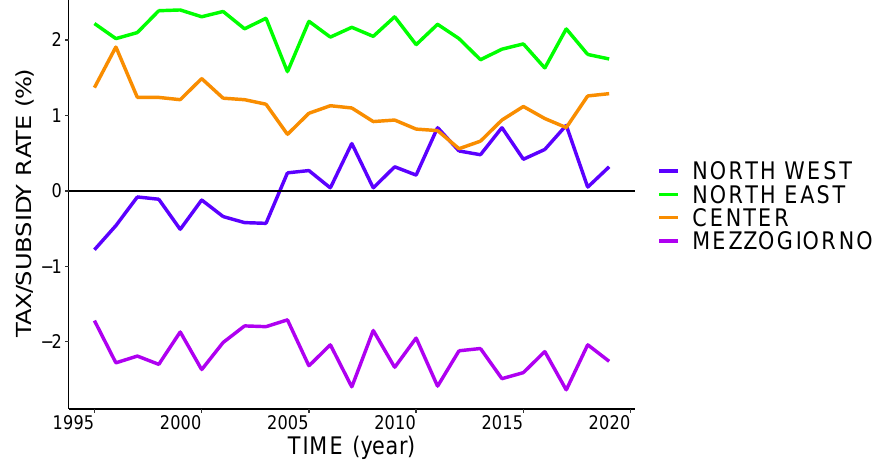
Figure 5. Tax/Subsidy rates for the Italian population aged 65 during 1995 to 2019 across macroareas (NUTS-1). Source: the author’s own elaboration on data from